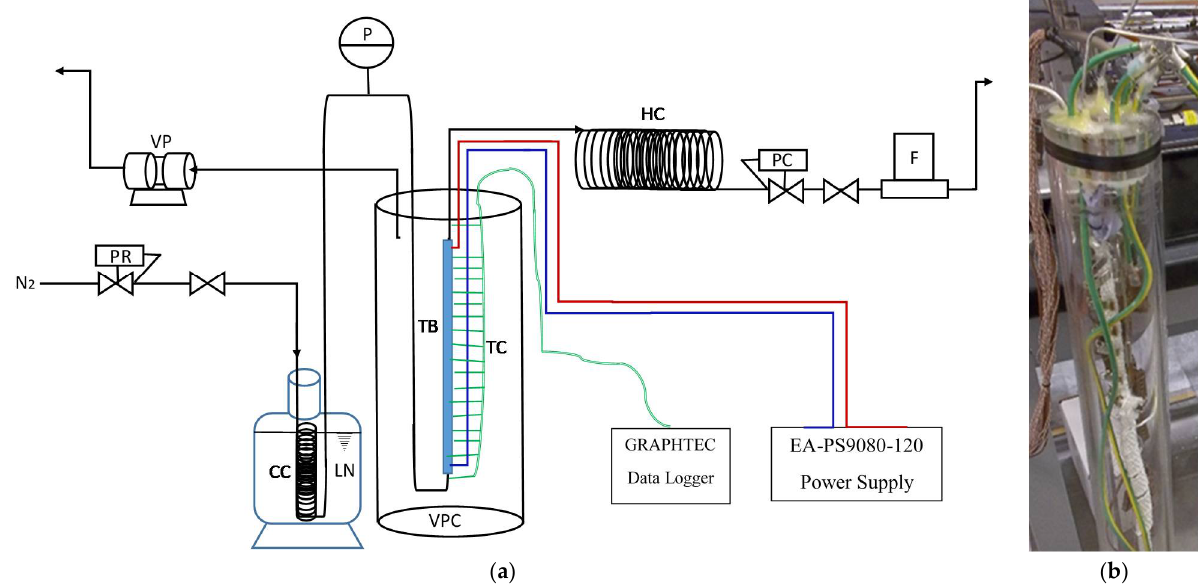
Figure 2. Schematics of the experimental system ( a ) and real picture of the test section ( b ). VP—vacuum pump; PR— pressure regulator; CC—cooling coil; LN—liquid N 2 ; P—pressure gauge; TB—test tube; VPC—vacuum Perspex chamber; TC—thermocouples; HC—heating coil; PC—pressure controller; F—gas flowmeter.